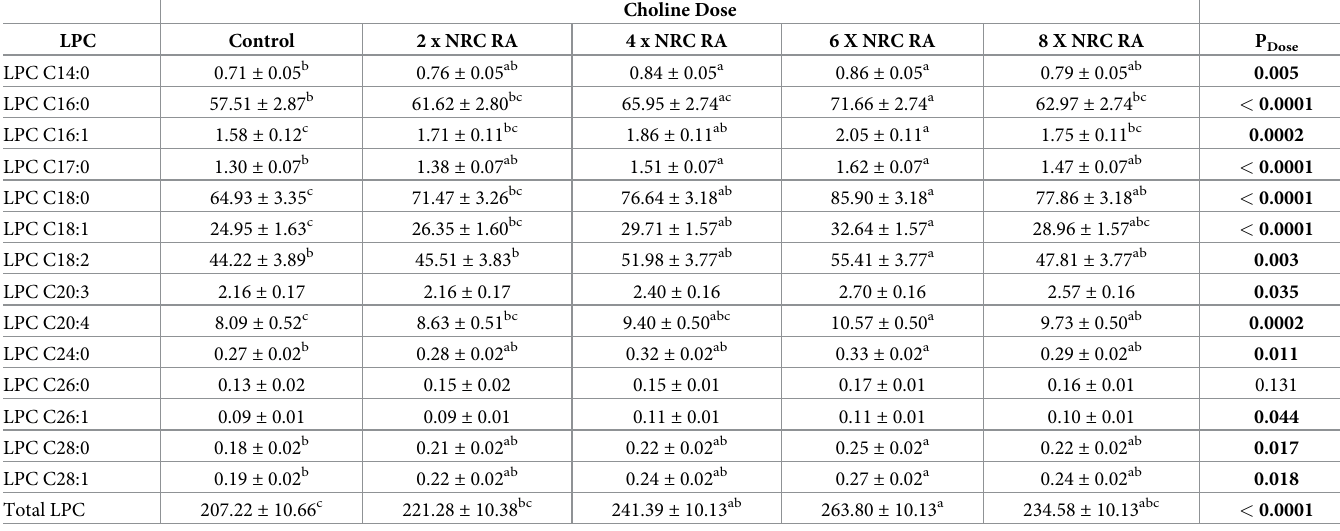
Values expressed as LSM ± SEM; Values in a row with superscripts without a common letter differ; P < 0.05, Repeated measures ANOVA with Tukey post-hoc test. LPC = lysophosphatidylcholine; DI-MS = direct infusion mass spectrometry; BW = body weight; NRC = National Research Council; RA = Recommended Allowance.